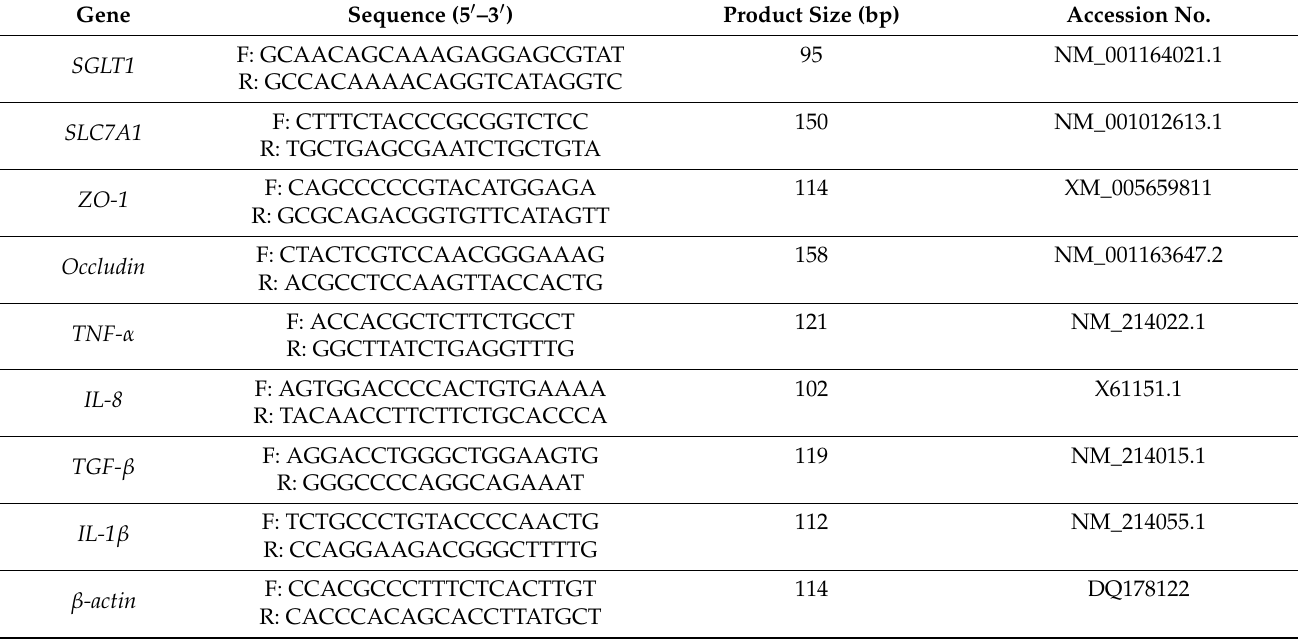
Table 3. Primer sequences used for quantitative